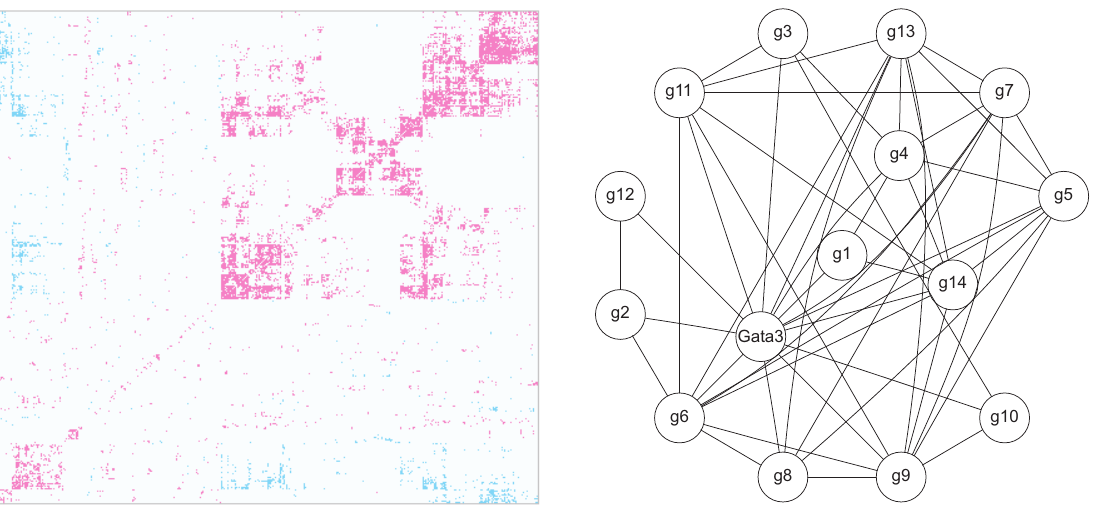
Figure 3: Visualization of the reconstructed coexpression network in the mouse T helper cell differentiation data. The left graph shows the hierarchical clustering of the coexpression network determined at the absolute correlation cutoff of 0.9. The rows and columns correspond to genes. Positive and negative correlations are indicated by red and blue, respectively. The right graph illustrates the subnetwork containing the transcription factor Gata3 and its first neighbors. The genes were associated an edge if their absolute correlation was over